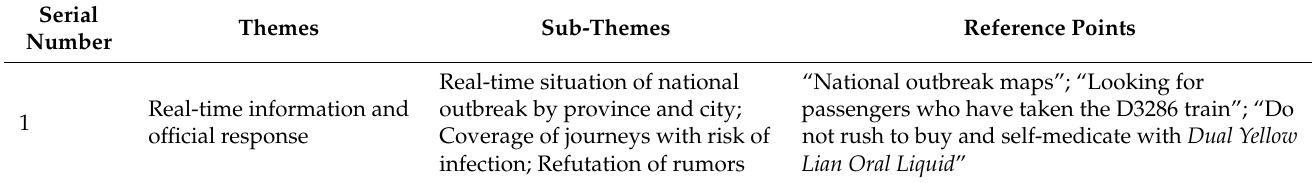
Table 1. Hot Search Themes